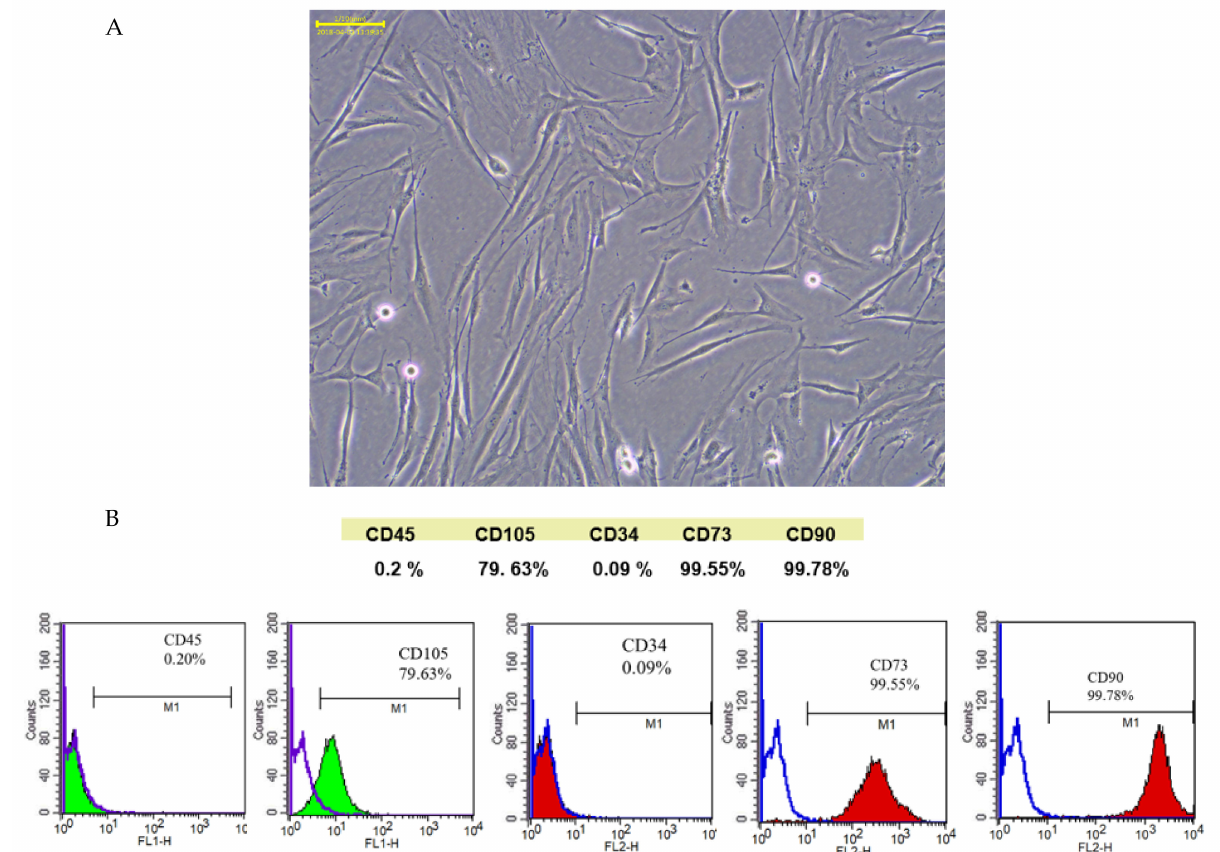
Figure 1. Morphology; scale bar is 0.1 mm ( A ) and cellular markers of SCAPs ( B ). SCAPs, stem cells from the apical